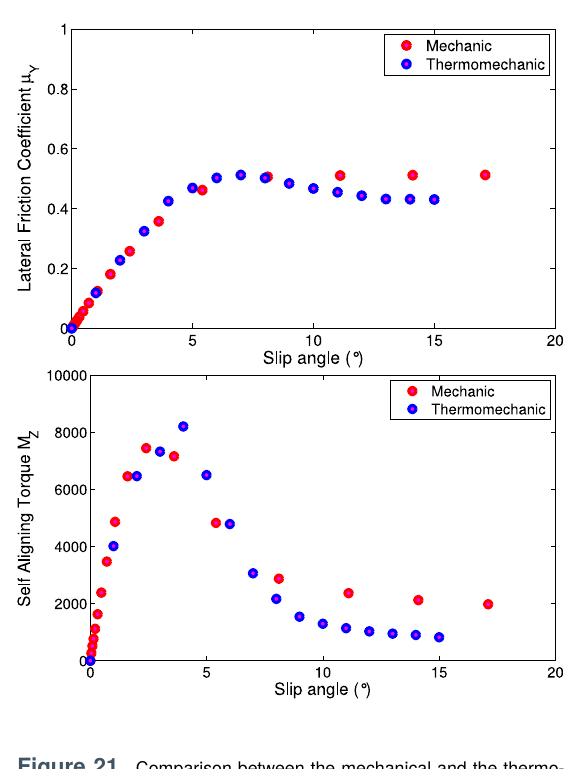
Figure 21. Comparison between the mechanical and the thermo- mechanical results obtained with constant µ 0 =0.6 and variable µ = µ ( T ) under given loading conditions ( p o = 15 bars, F Z = 250 kN, v = 50 km/h, β = 16°).